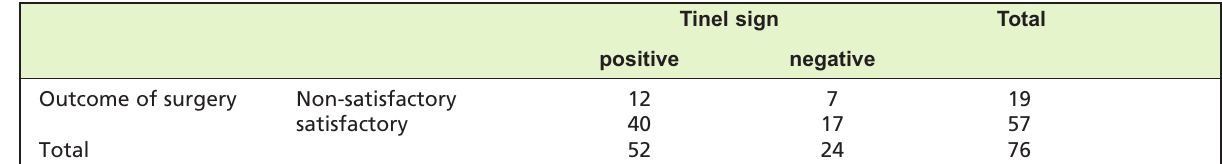
Association between Tinel sign and Outcome of surgery Table V: The outcome of surgery - Tinel sign Crosstabulation